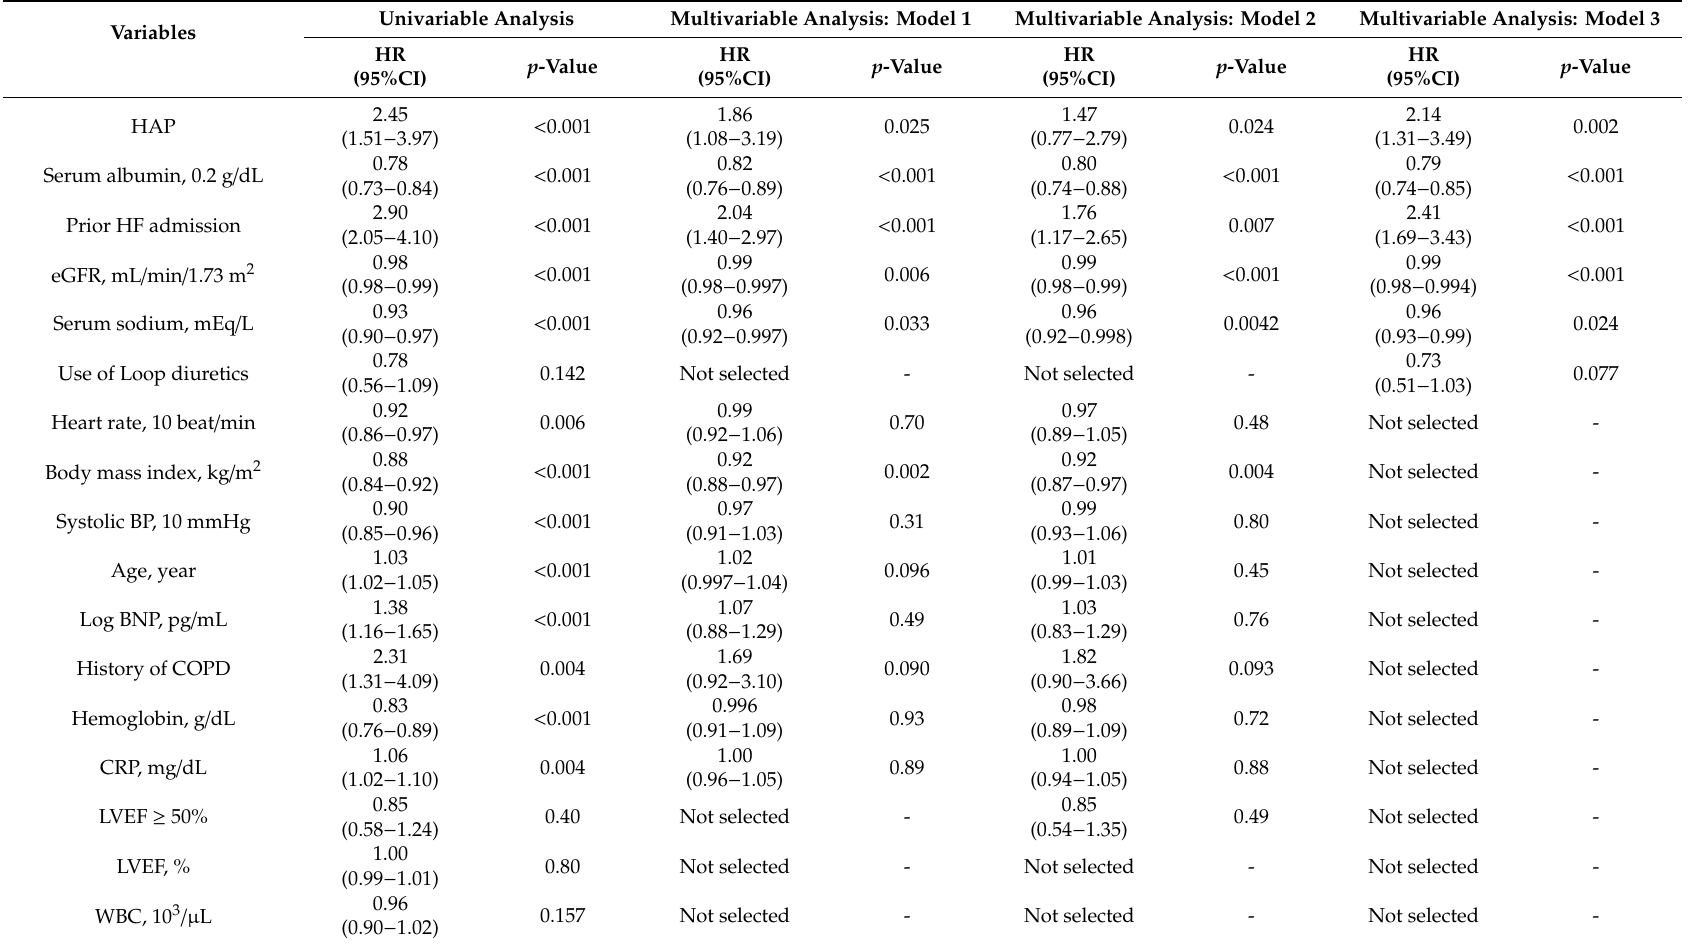
Table 3. Cox proportional hazards model for determinants of all-cause death after